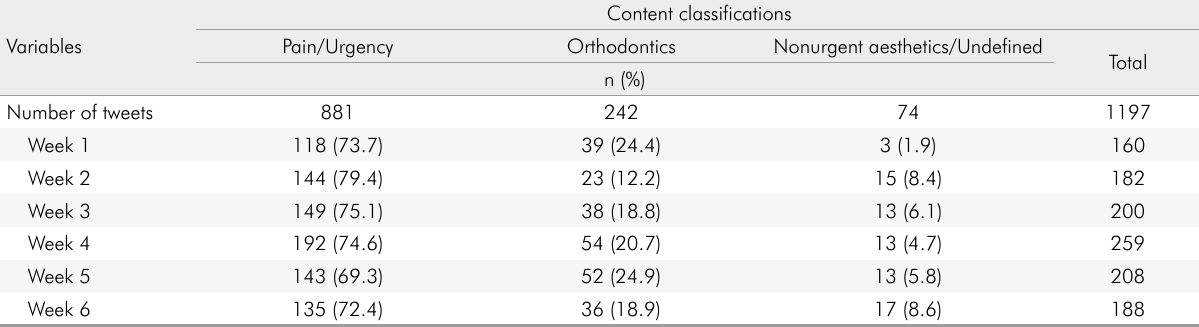
Table 2. Frequency of tweets according to content classifications of the type of self-reported treatment needed during the COVID-19